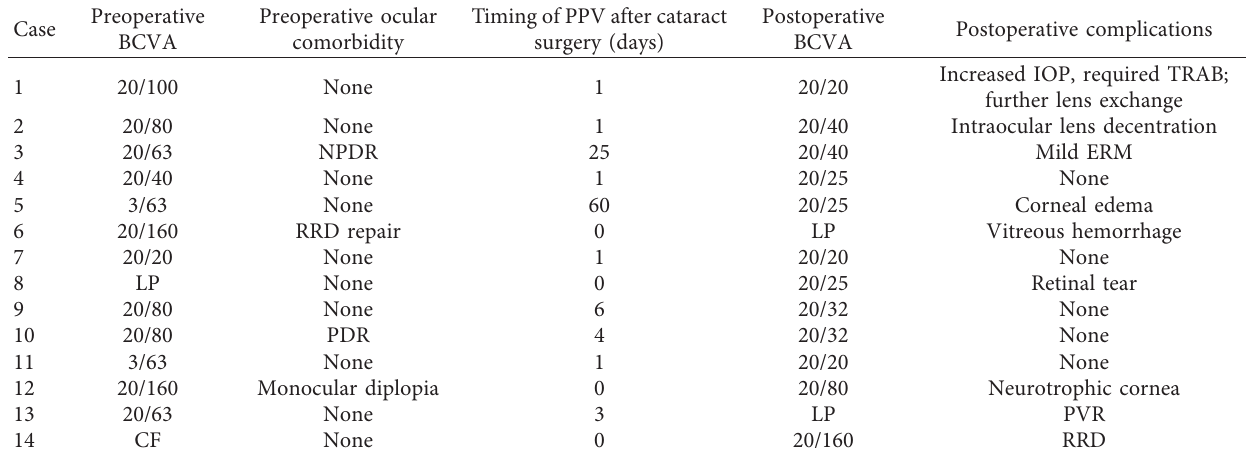
Table 2: Details of eyes that required pars plana vitrectomy (PPV) for fragment